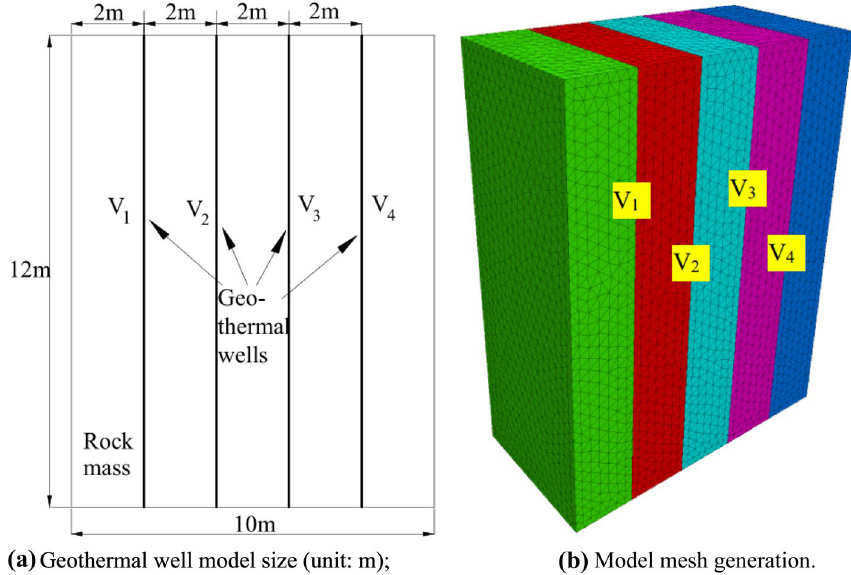
Figure 2. Geothermal well model size and mesh generation.